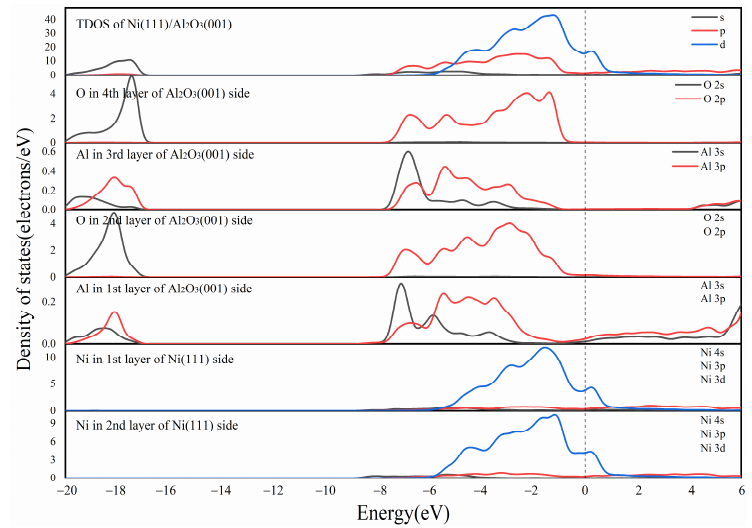
Figure 3. Total DOS (TDOS) and PDOS of the interfacial atoms in the Ni(111)/Al 2 O 3 (001) system. For the Ni 3 Al(111)/Al 2 O 3 (001) interface, one Al atom and three Ni atoms are present in the first and second layers on the Ni 3 Al(111) side. The PDOS is shown in Figure 4. The PDOS change on the Al 2 O 3 (001) side is similar to that of the Ni(111)/Al 2 O 3 (001) interface. The 3p orbitals of the first layer of the Al atom on the Al 2 O 3 (001) side are located between − 6 and − 3 eV. The PDOS peak of the 3d orbitals of the first-layer Ni atoms on the Ni 3 Al(111) in first layer is slightly more intense than Ni atoms on the Ni 3 Al(111) in second layer, and its energy shifts toward a higher value. Different from the Ni(111)/Al 2 O 3 (001) interface, the orbital shift of the Ni atoms in the first layer on the Ni 3 Al(111) side leads to a decrease in the overlap of the PDOS of the Ni and Al atoms, so the Ni 3 Al(111)/Al 2 O 3 (001) interface weakens the Ni–Al bond. The overlapping of the PDOS of the first-layer Ni atoms on the Ni 3 Al(111) side and the O atoms on the Al 2 O 3 (001) side mainly occurs on the right-hand side of the Fermi level, which has an inhibitory effect on the bonding of Ni and O. Total DOS and PDOS of the interfacial atoms in the Ni 3 Al(111)/Al 2 O 3 (001) system are shown in Figure 4.